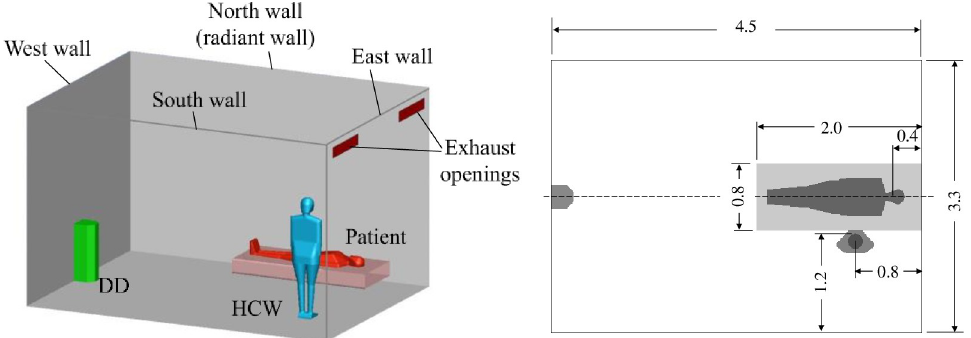
Fig 1. Experimental setup. Numerical setup for EN cases (Table